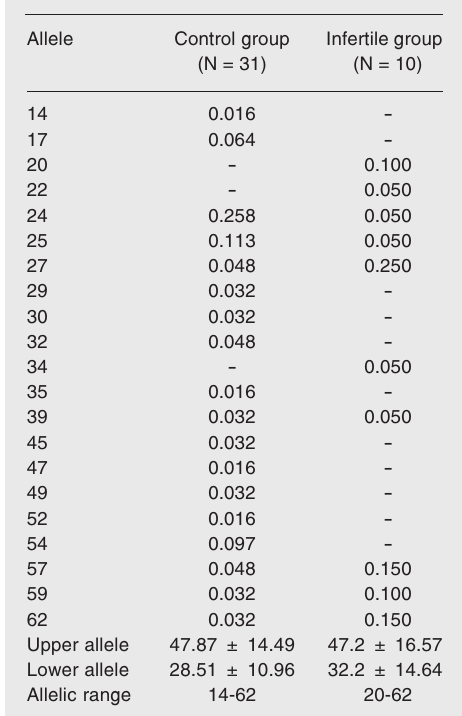
Table 1. Allelic frequency, average size of alleles and allelic range of control and infertile